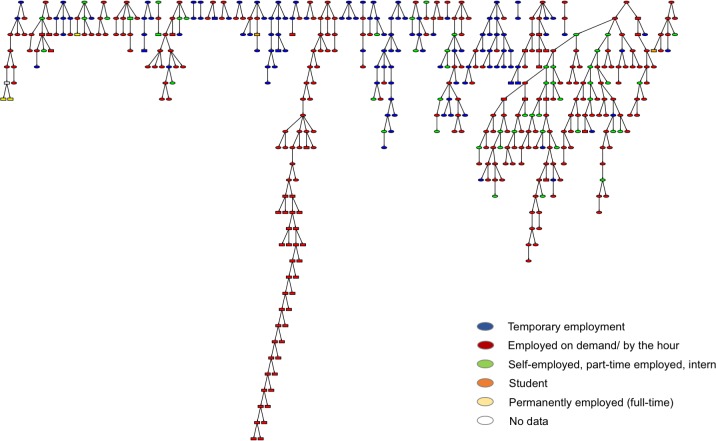
Recruitment networks showing employment type of submitted surveys.Squares indicate that the submitted survey is ineligible.